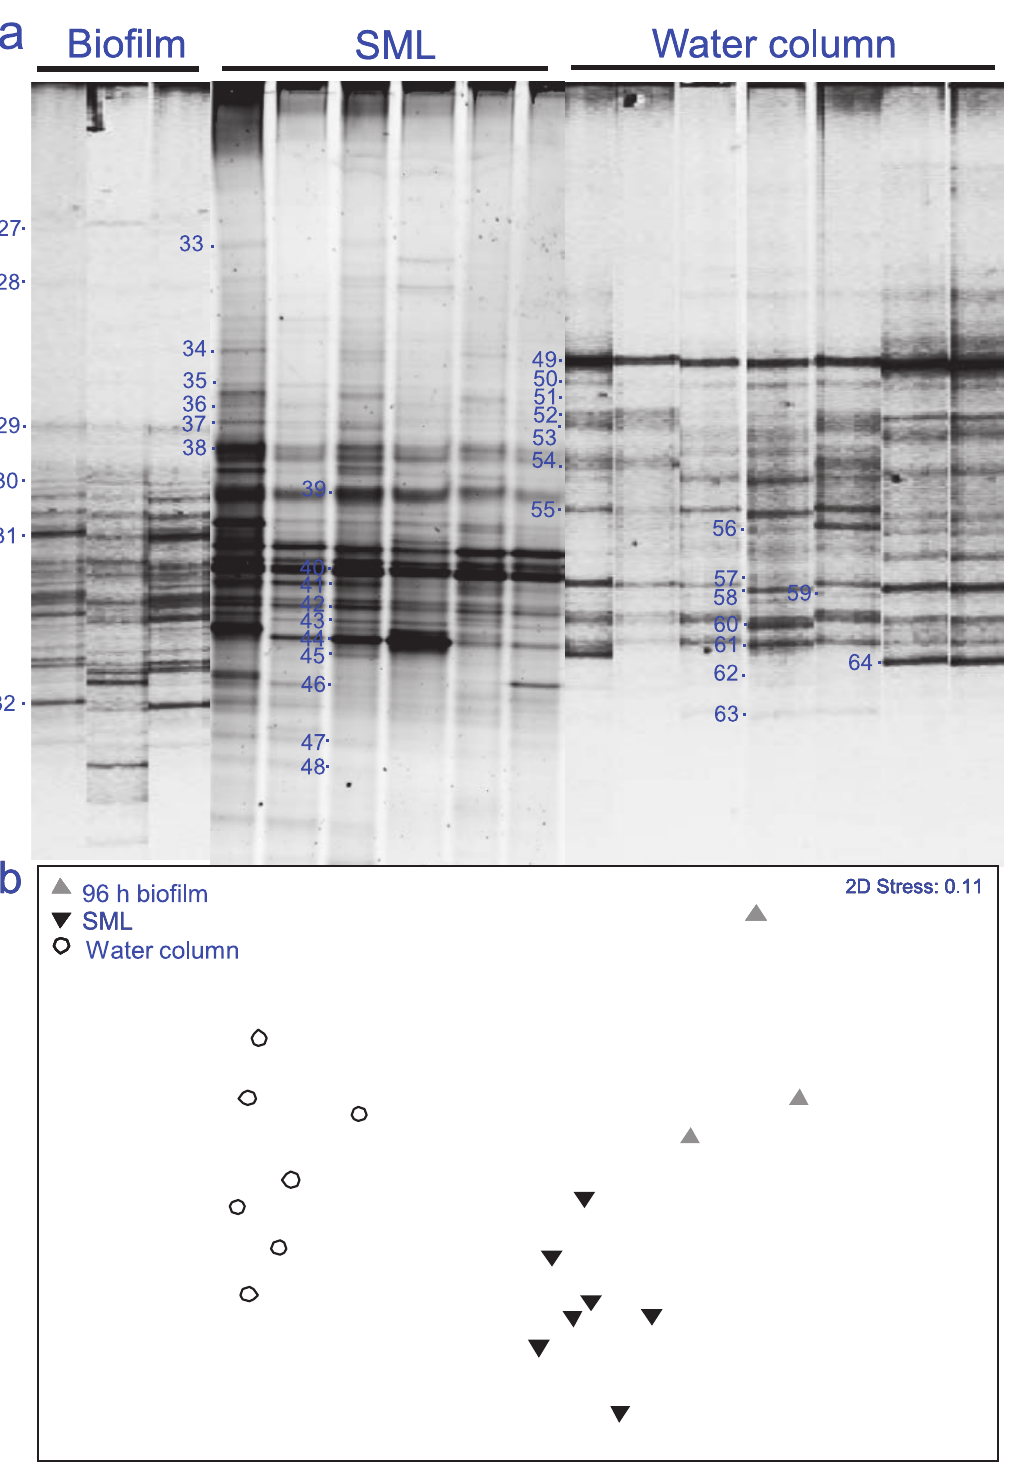
Figure 5. Variation in 16S rRNA gene fingerprints between sample types (Biofilm, SML and water column), for March 2009 (summer); (a) Composite DGGE image standardised for gel-to-gel comparison using BioNumerics, (b) Multidimensional scaling (MDS) plot based on relative band intensity from composite DGGE profile. doi:10.1371/journal.pone.0021195.g005 Rypien et al. [16] found that pathogenic Vibrios , in particular V. shiloi and V. coralliilyticus, are usually inhibited by other coral- associated bacteria found in healthy coral samples. During periods